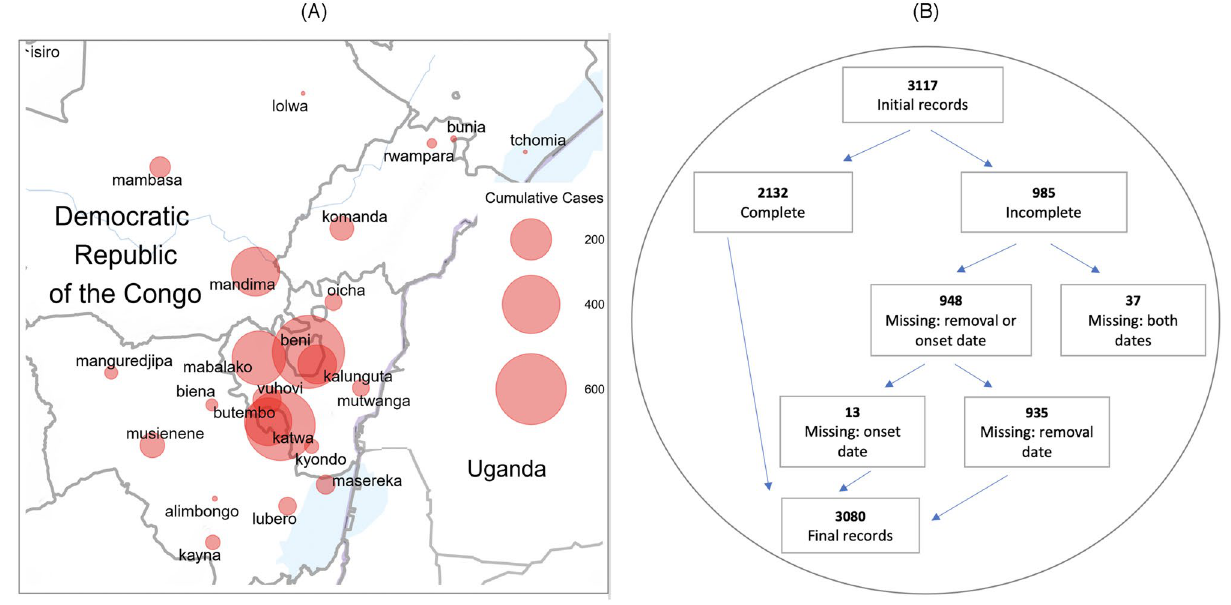
Figure 1. DRC Ebola dataset. ( A ) The spatial distribution of 3481 EVD cases across the northern DRC health zones during Ebola 2018–2020 outbreak. ( B ) The flowchart of personal records available up to September